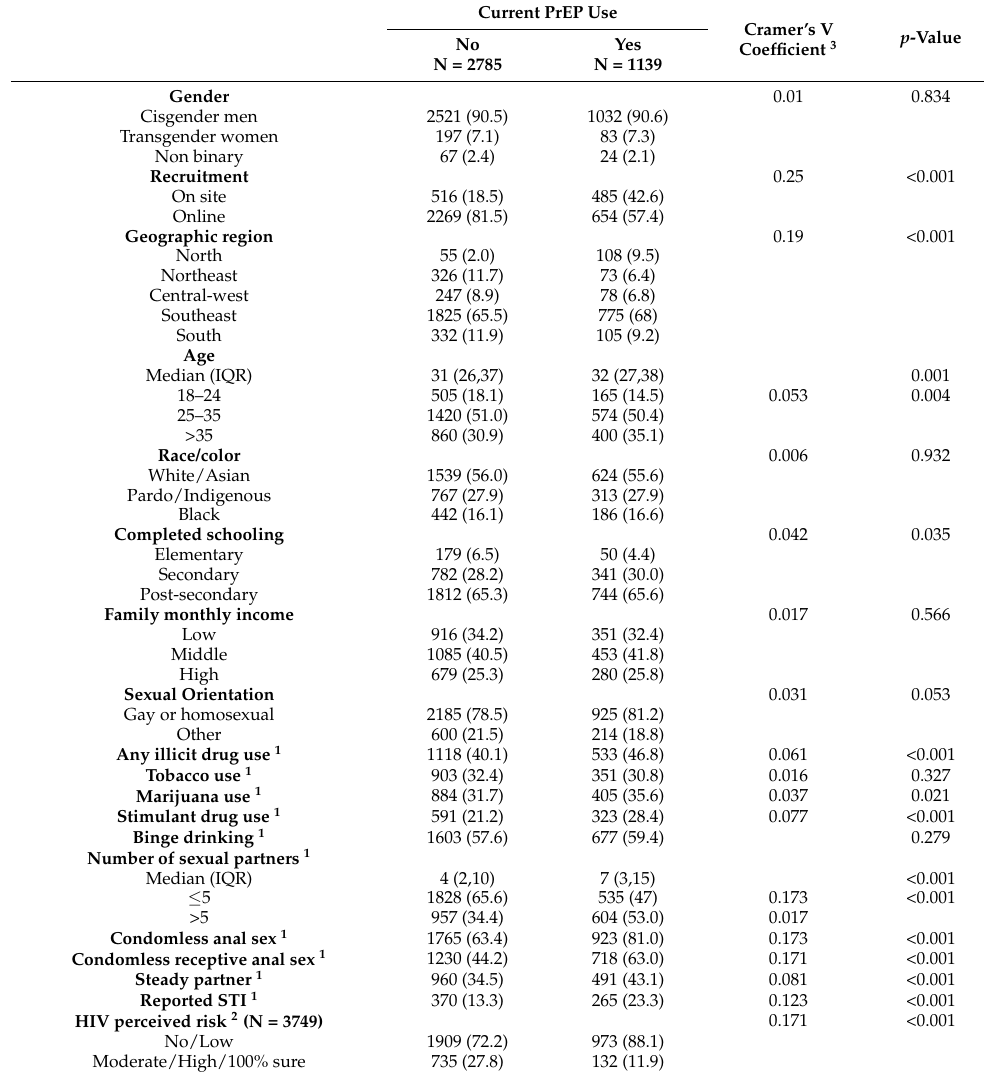
Table 1. Sociodemographic characteristics, substance use, and sexual behavior of the study population according to current PrEP